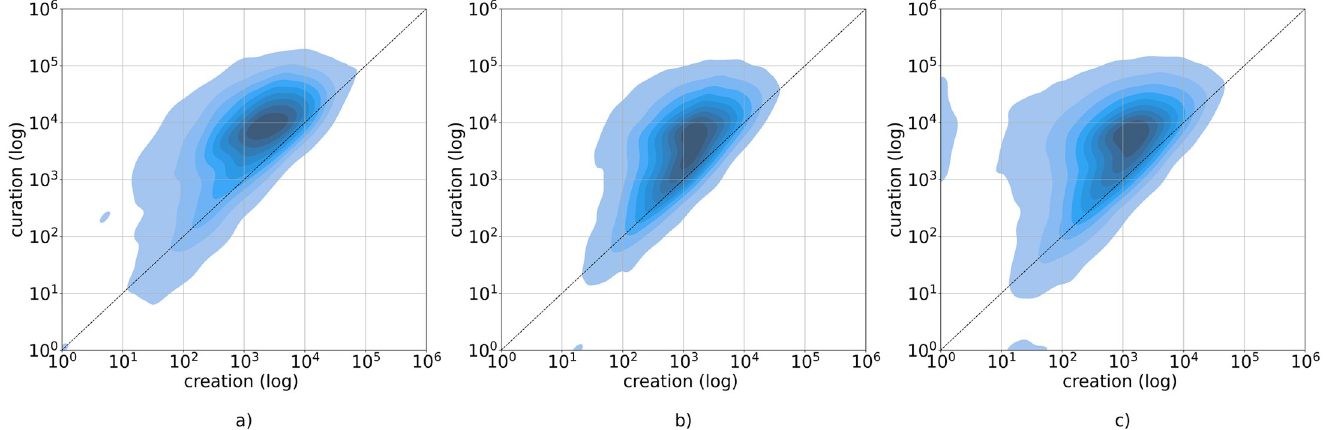
Fig 7. User’s creation and curation, for each currency. Scatter plots (obtained by Kernel Density Estimation—KDE) relating curation (number of votes) and creation (number of posts and comments), for each of the three currencies: a) STEEM, b) SBD and 3) Steem Power. On the x-axis: the creation activity. On the y-axis: the curation activity. Darker colored areas correspond to higher density.